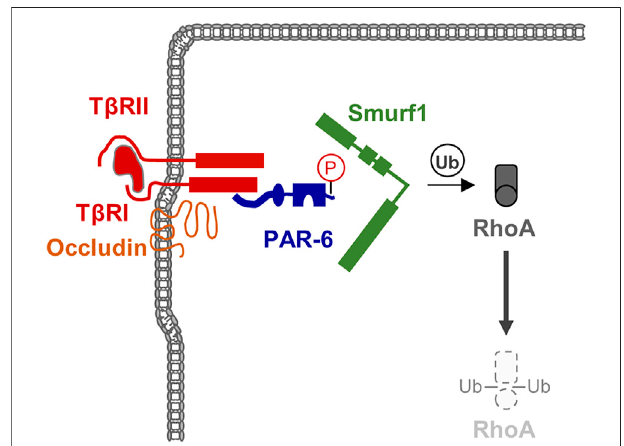
FIGURE 4 | TGF β signaling triggers RhoA degradation during EMT. TGF β receptors are localized at theTJ through the interaction of T β RI with Occludin. TGF β signaling triggers phosphorylation of PAR-6 resulting in the recruitment of the ubiquitin ligase Smurf1 and subsequent ubiquitination and degradation of the local pool of